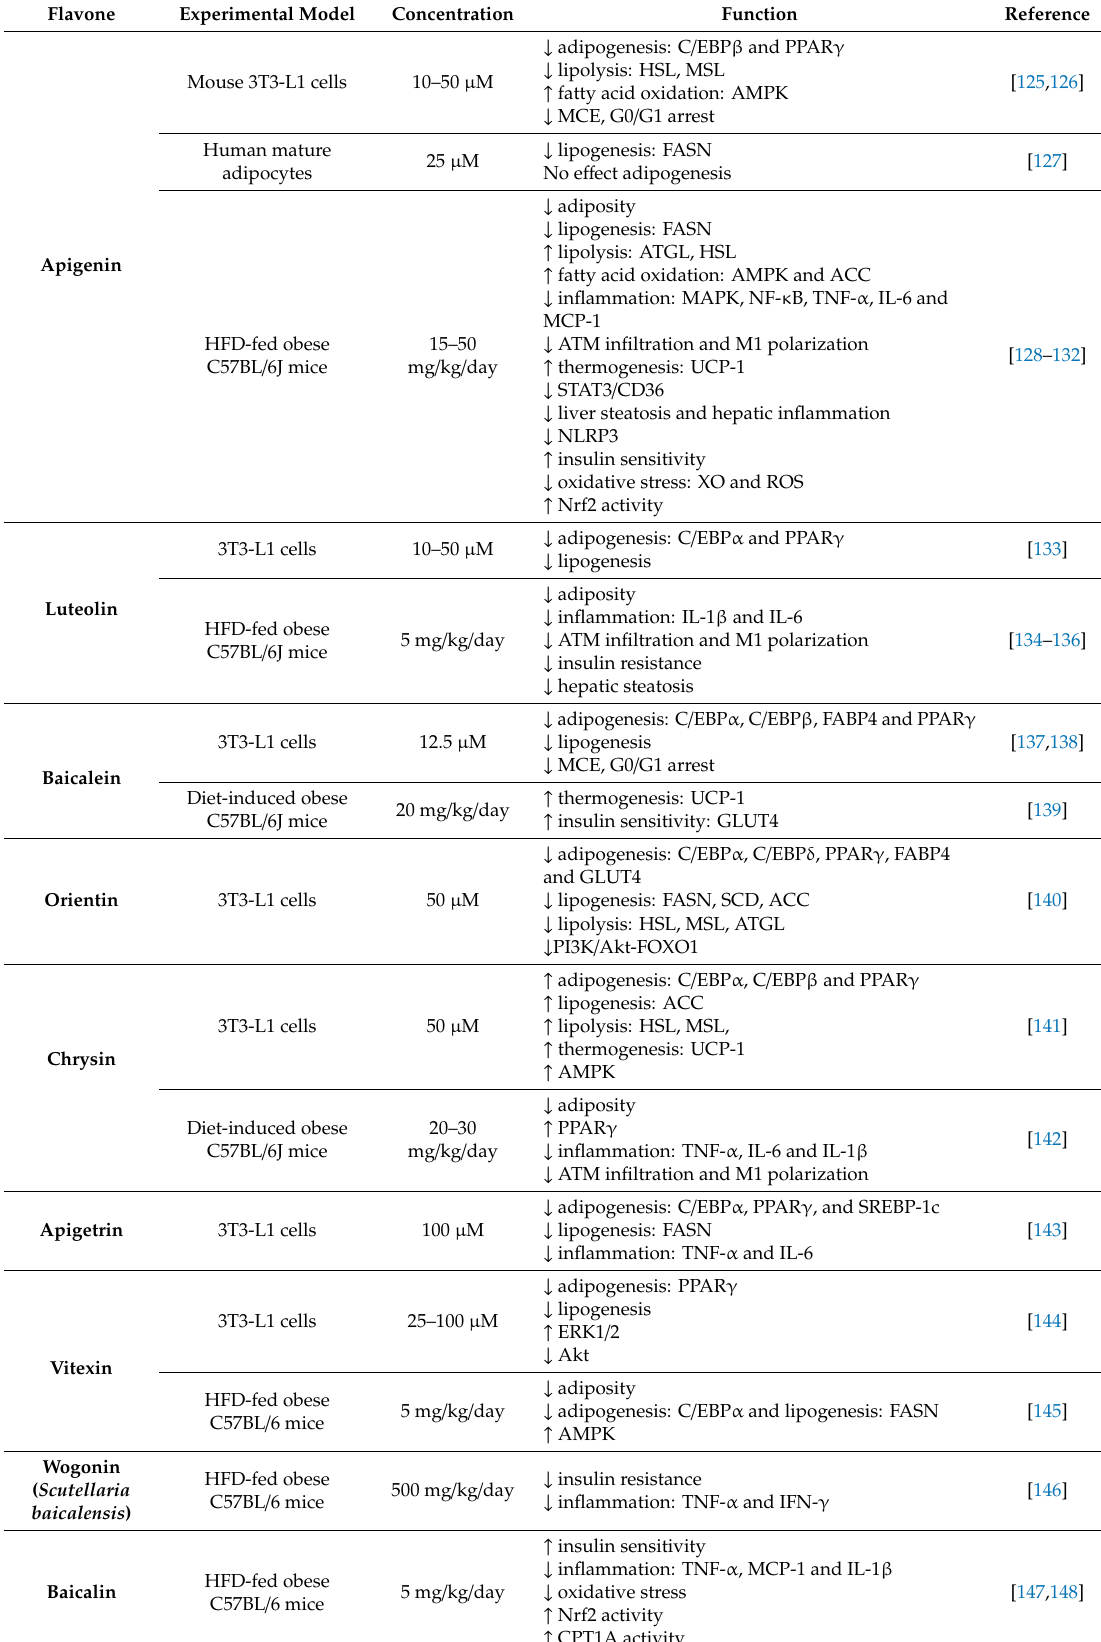
Table 1. Flavones and their functional roles in obesity and its associated inflammation.